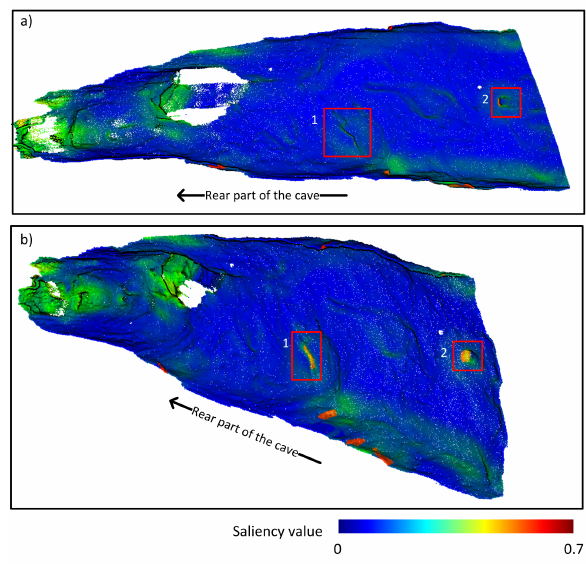
Figure 5. Point-based saliency estimation of the right wall of the cave. Occlusions do not affect the estimation. Details 1 and 2 are later extracted and are shown in Fig. (6) depth (2-6 m). Sixty-six sinkholes are scattered along the fan, also in varying sizes, with perimeters between 5 m and 40